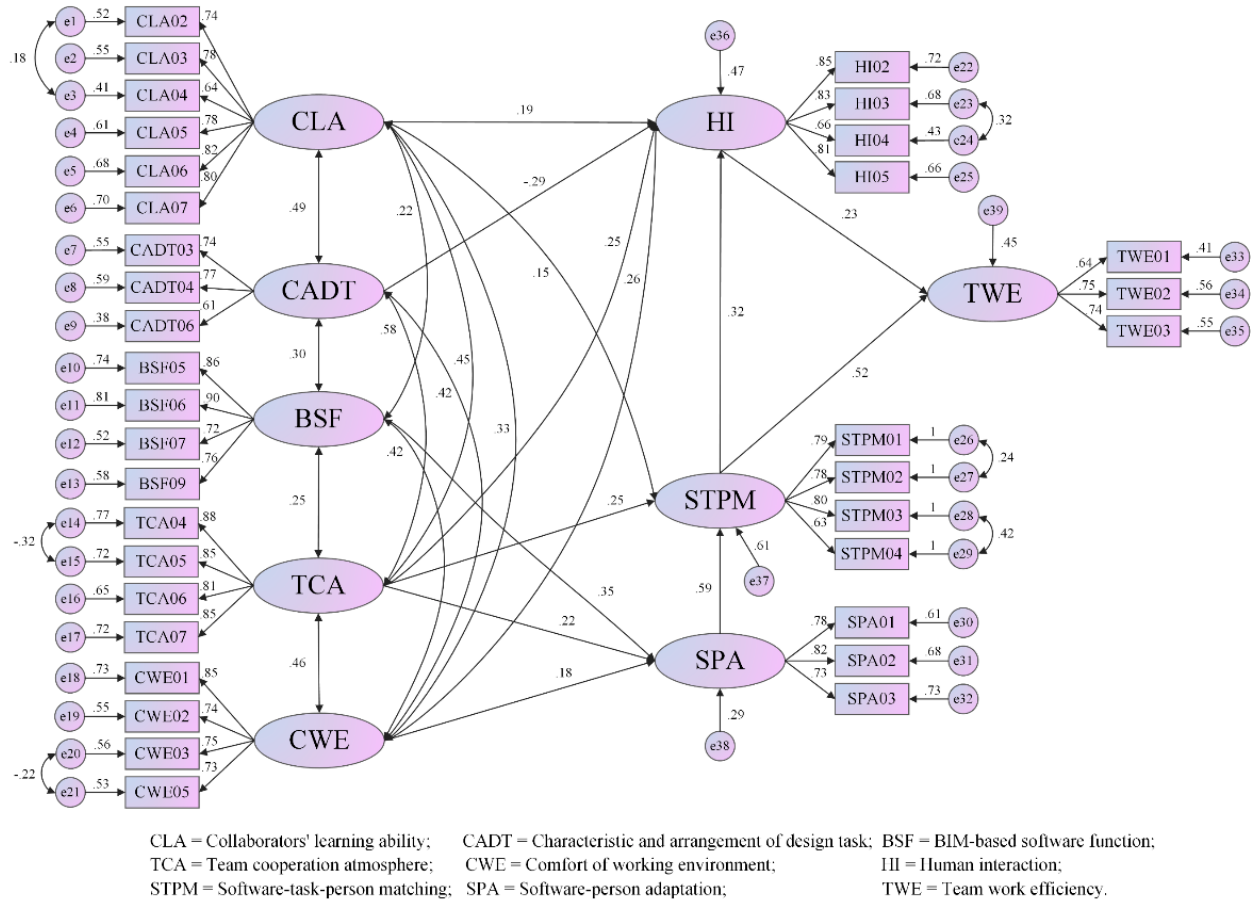
Figure 4. Standardized estimation of the final model. Table 8. Regression weights in the final Table 7. Goodness-of-fit of the final structural model.